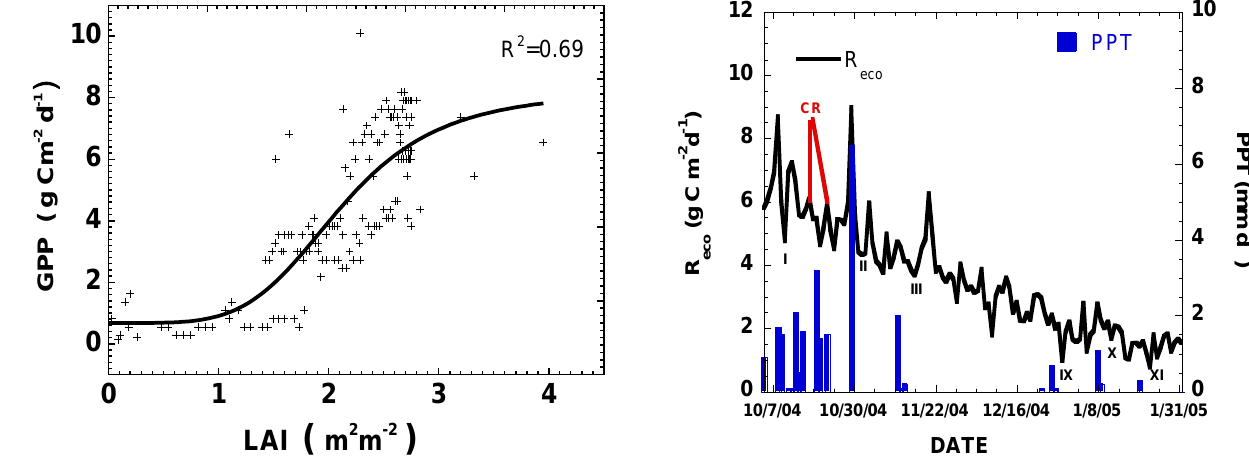
Fig. 7. Examples of influence of rain events on the ecosystem respiration ( R eco ) from 1 October 2004 to 10 February 2005. Data are the daily total R eco and precipitation ( PPT ).